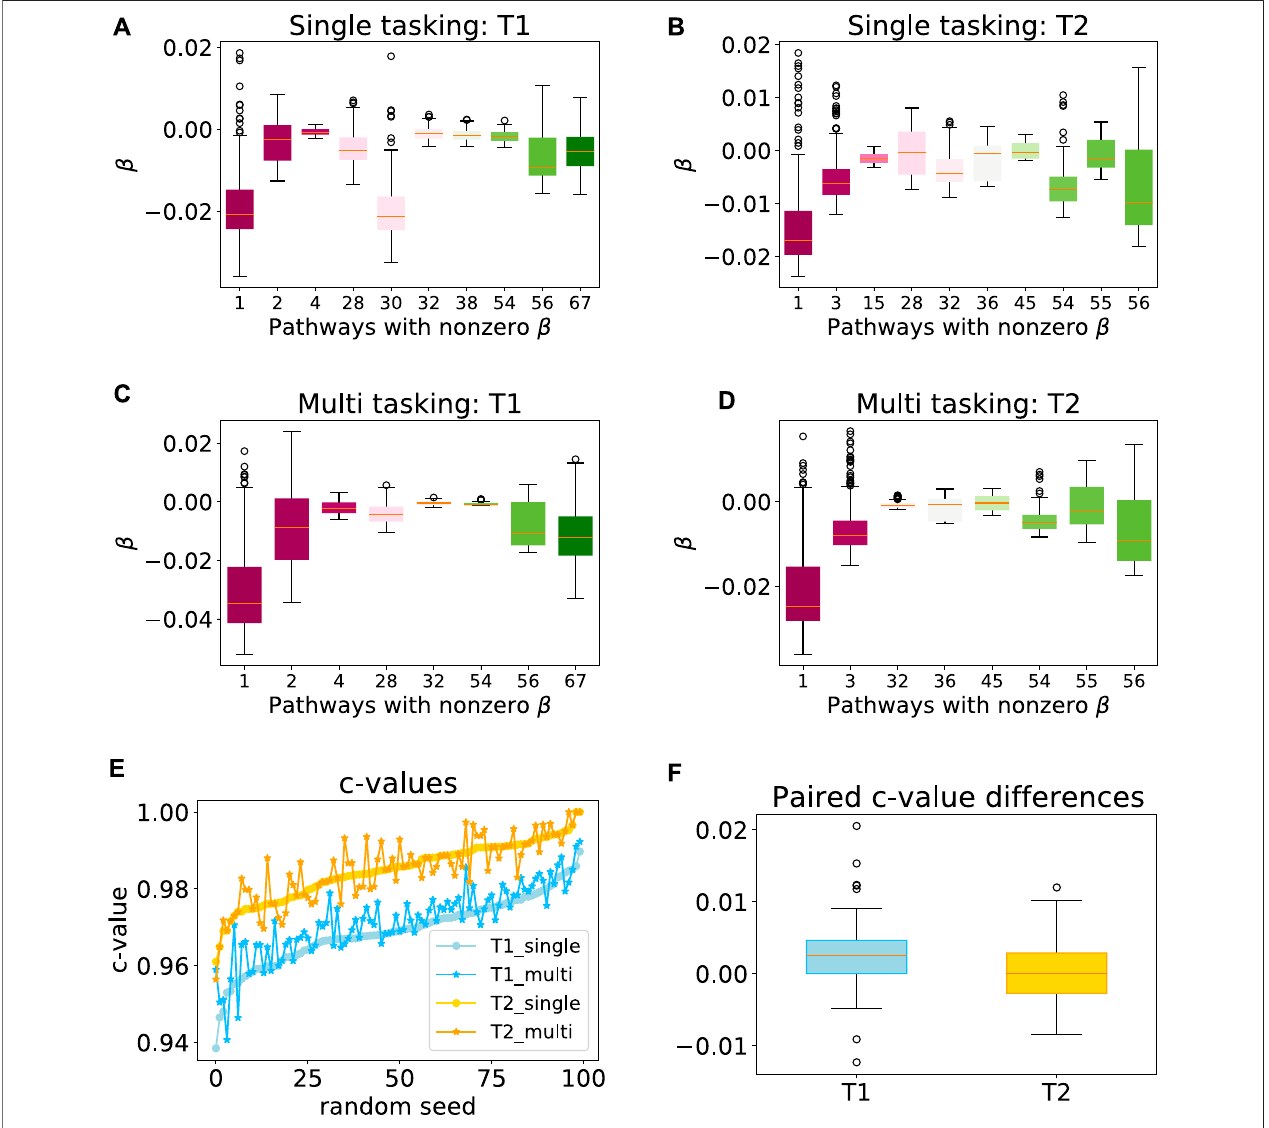
FIGURE4| Performance ofthemulti-taskmodelonasyntheticdataset.Boxplotsshowing therangeofmodelcoef fi cients β bypathway forstandardgrouplasso (A – B) andmulti-taskgrouplasso (C – D) on T 1 and T 2 datasets.Outofthe69totalpathways,onlypathwayswithatleastonenon-zerocoef fi cient areshown.Bydesign, activity of pathways 1 and 2, and one and three were predictive for patient survival for T 1 and T 2 , respectively. The average congruence coef fi cient of β is 0.81 ( T 1 ) and 0.96( T 2 )forsingletasking,and0.80( T 1 )and0.91( T 2 )formultitasking(e – f) c -valuesandboxplotsofthepaireddifferencefor100randomseedsforsingleandmulti- tasking for T 1 and T 2 synthetic data. Note that T 1 and T 2 are sorted independently, so their random seed numberings do not correspond. The t -test p -values are 1.35 · 10 – 7 ( T 1 ) and 0.49 ( T 2